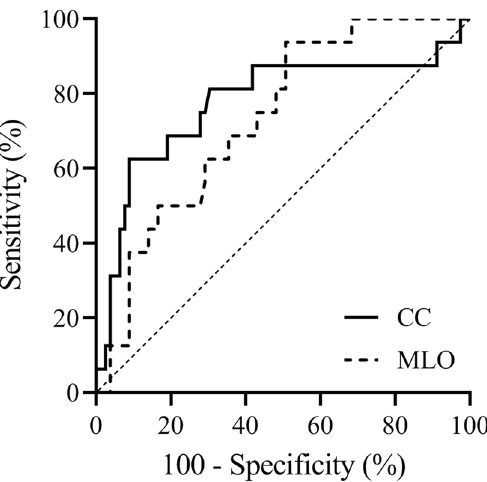
Figure 3. Diagnostic efficiency ROC curve of CC and MLO view grey value reduction